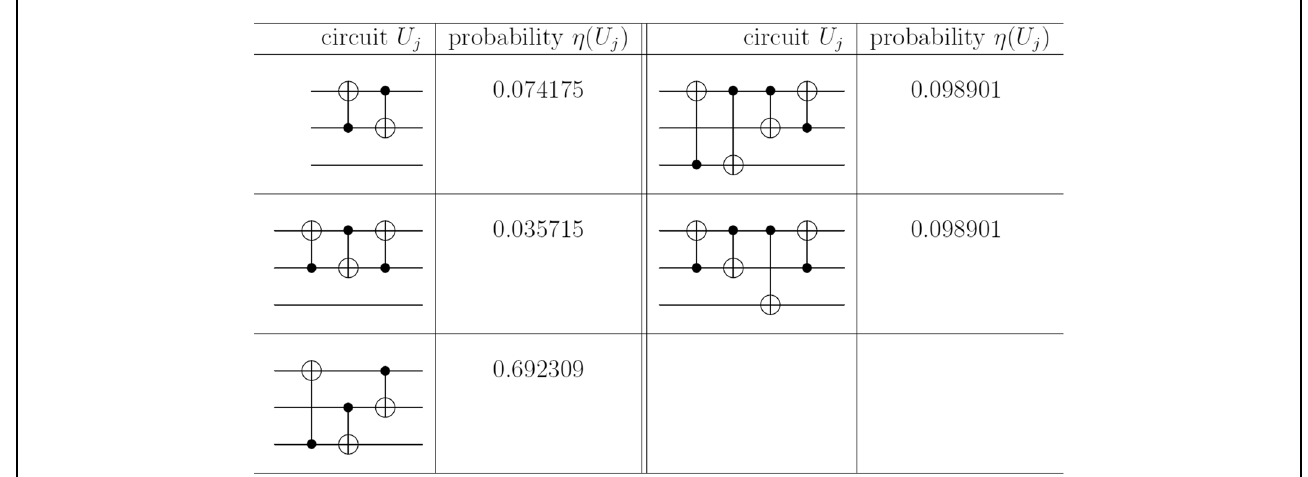
Table 4. Optimal three-qubit Clifford 2-design with the average cost 3.12363. . . . For comparison, the full Clifford group C 3 has the average cost 3.50937. . .